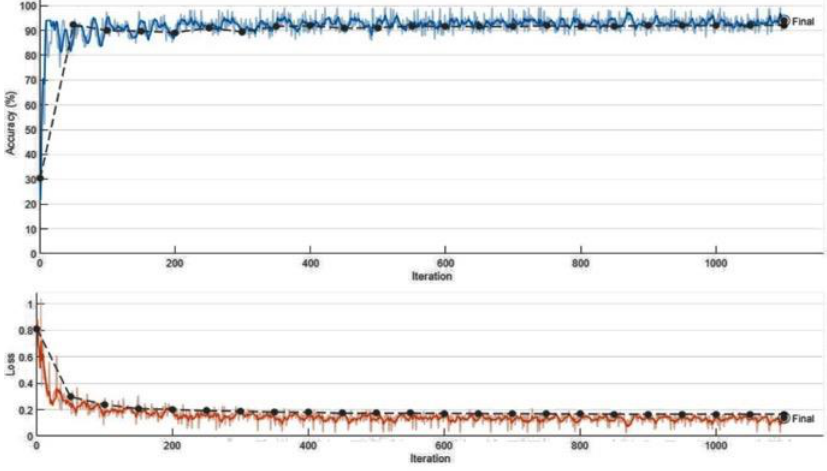
Figure 24. Accuracy and loss graphs for the first training set.